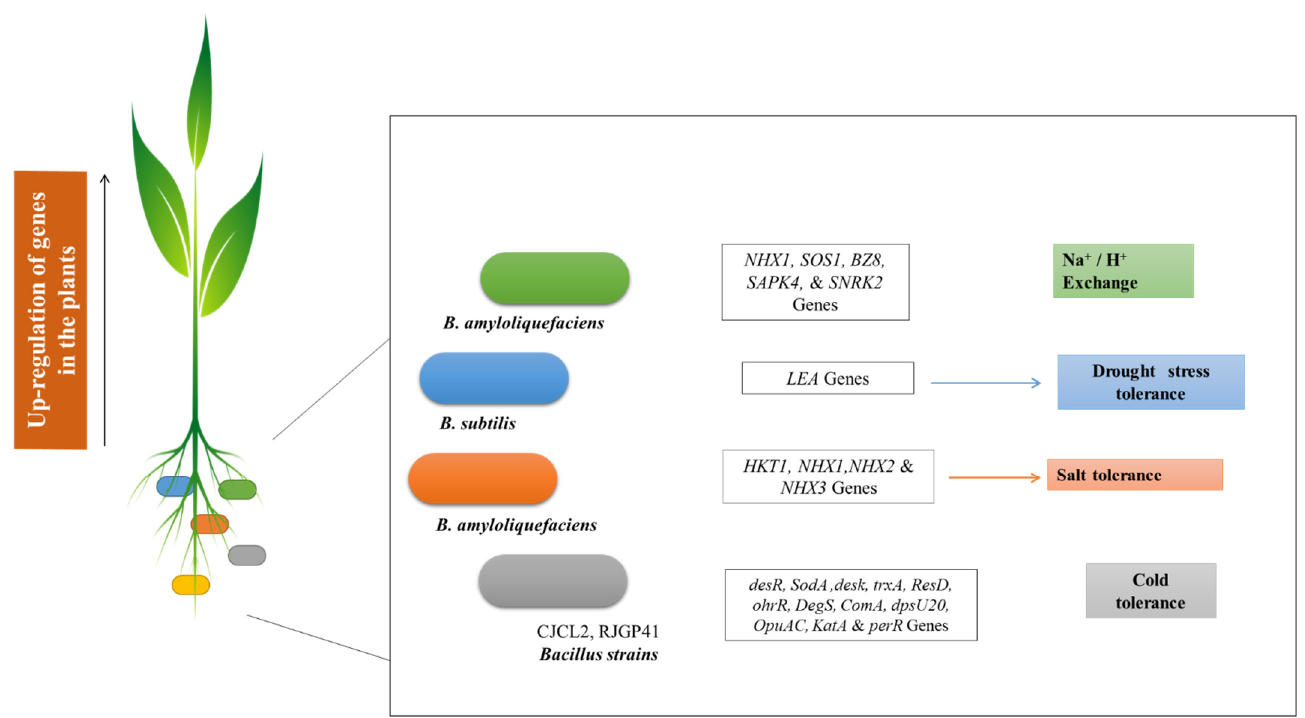
Figure 3. Bacillus spp. induced expression of genes in plants grown under various stress conditions.